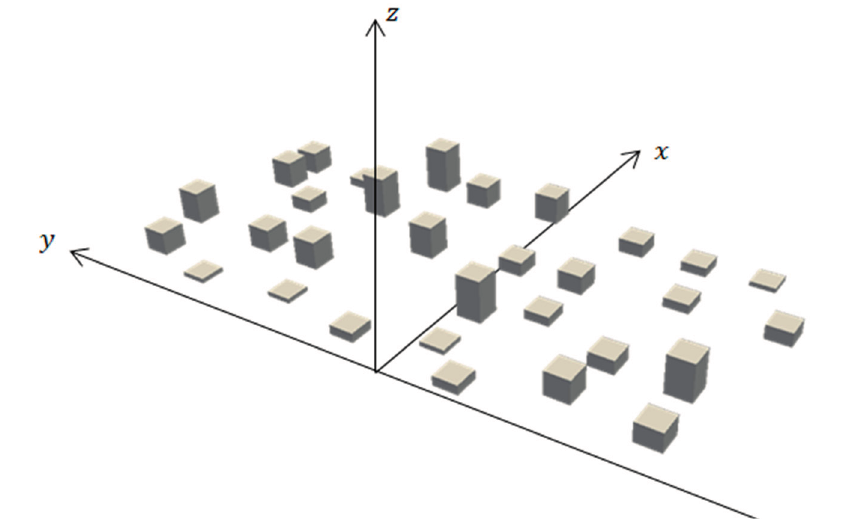
Figure 1. Geometry of the roughness-cubes lying on the